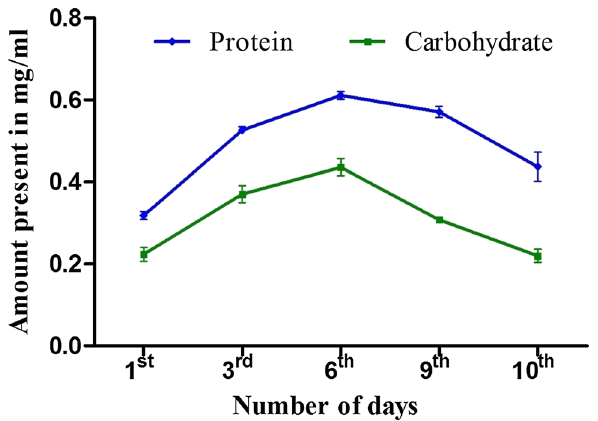
Fig. 9 Changes in the protein and carbohydrate content of Chlorella sp. SRD3 during effluent treatment